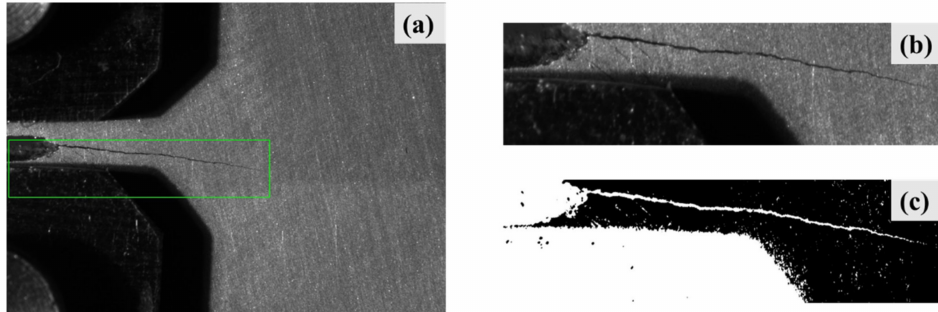
Figure 15. Results after CNN detection and threshold segmentation: ( a ) crack detection results; ( b ) extracted crack region; ( c ) crack region after threshold